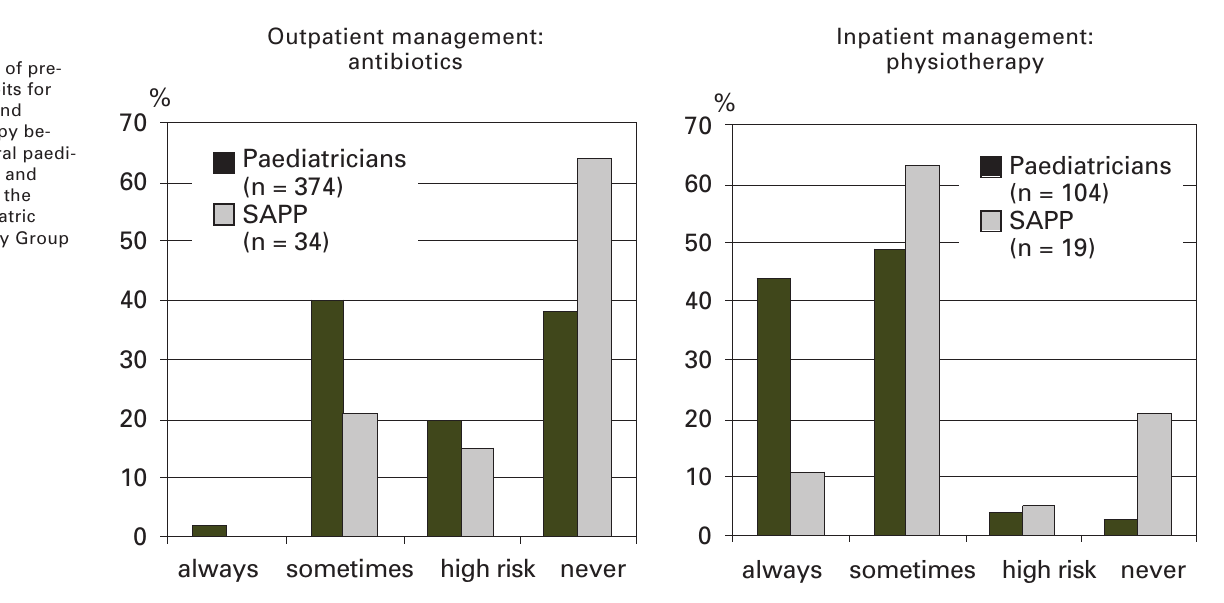
Comparison of pre- scribing habits for antibiotics and physiotherapy be- tween general paedi- atricians ( ! ) and members of the Swiss Paediatric Pulmonology Group (SAPP) ( ! ).